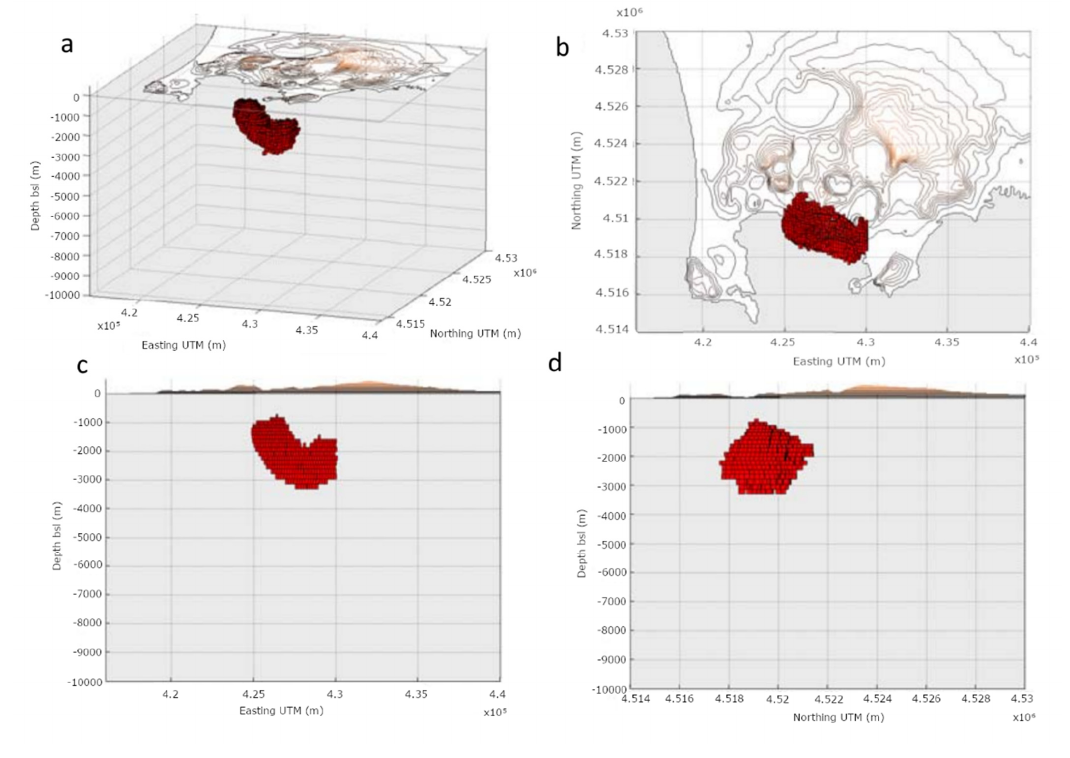
Figure 12. Source location, depth and shape for deflation period of 2005–2007. ( a ) 3D perspective; ( b ) map view of source below Campi Flegrei caldera; ( c ) EW vertical profile; ( d ) NS vertical profile